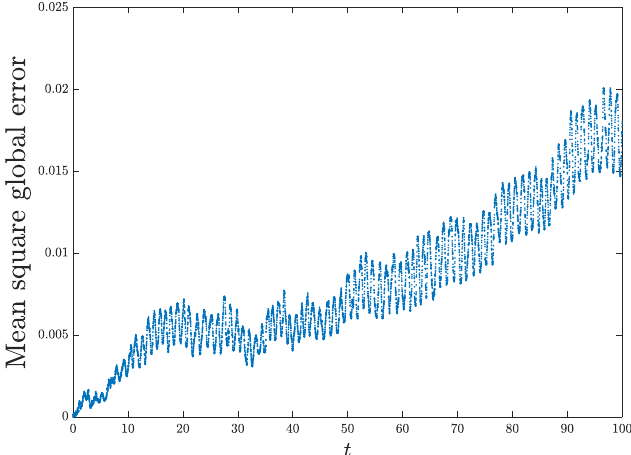
Figure 3. Global mean square errors for Example 1 with h = 0.1.